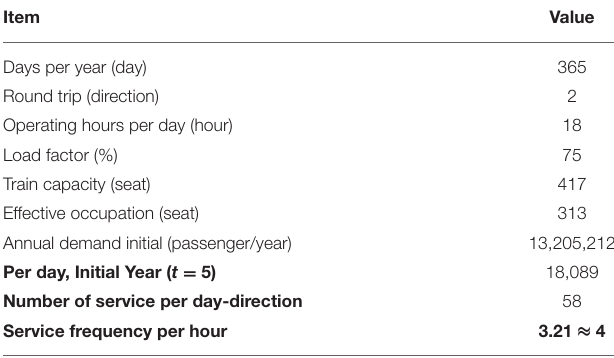
TABLE 16 | The total operator costs ( e